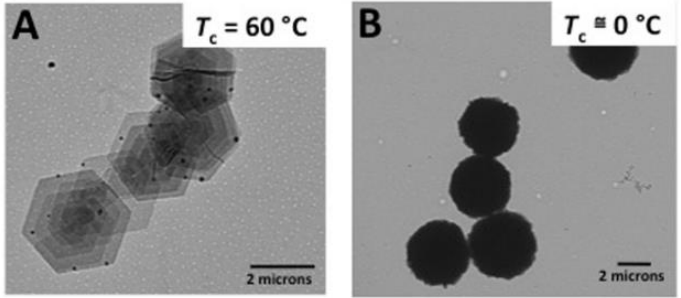
Figure 4. Transmission electron microscopy (TEM) images of i PB1( A ) hexagonal and ( B ) circulated 223